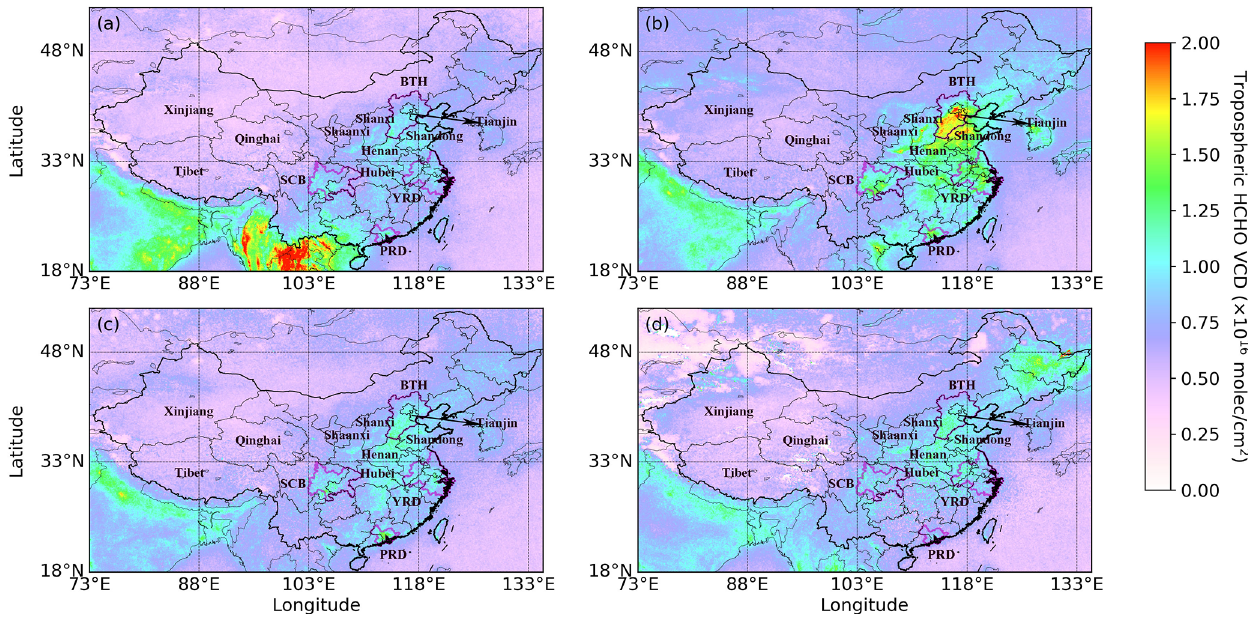
Figure 12. The spatial distribution of average TROPOMI operational tropospheric HCHO VCDs over China on a 0.1 ◦ × 0.1 ◦ grid in spring (a) , summer (b) , autumn (c) and winter (d)